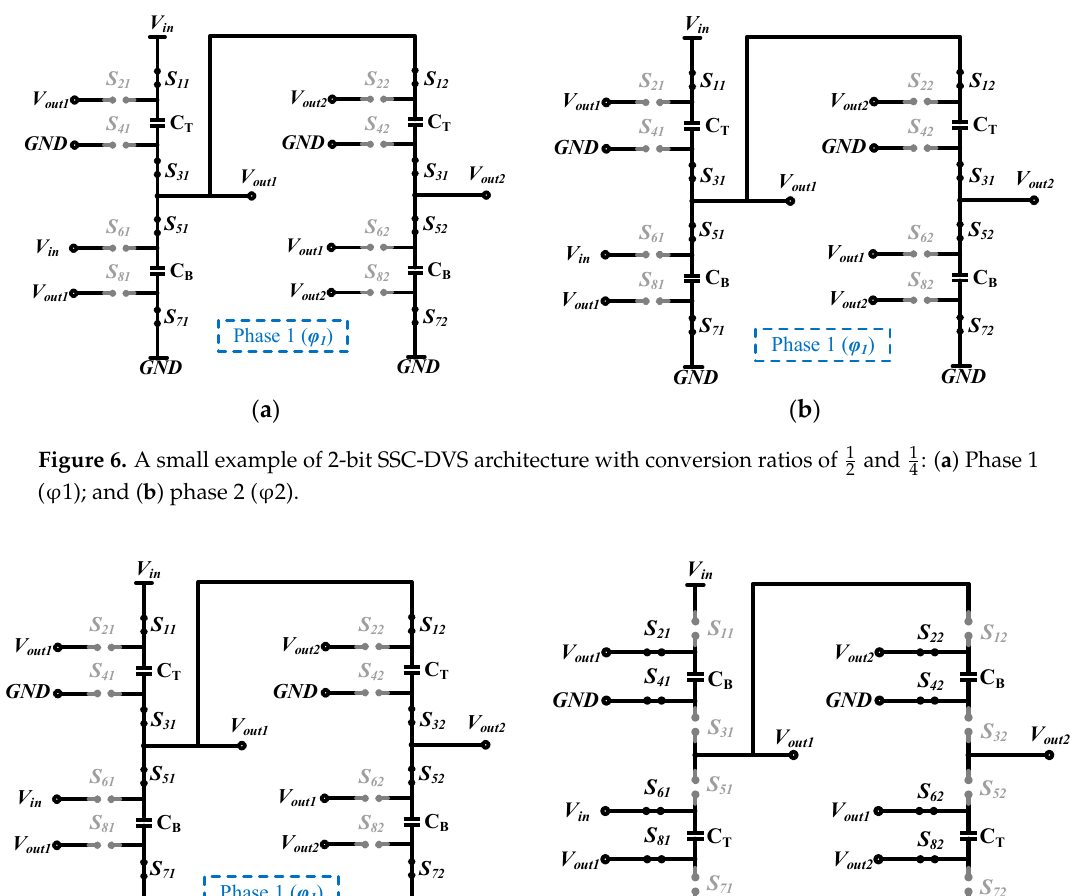
Figure 5 . A 2-bit example of the proposed SSC-DVS architecture with two configurations of: ( a ) D 1 D 2 = (00) 2 ; and ( b ) D 1 D 2 = (01) 2 .